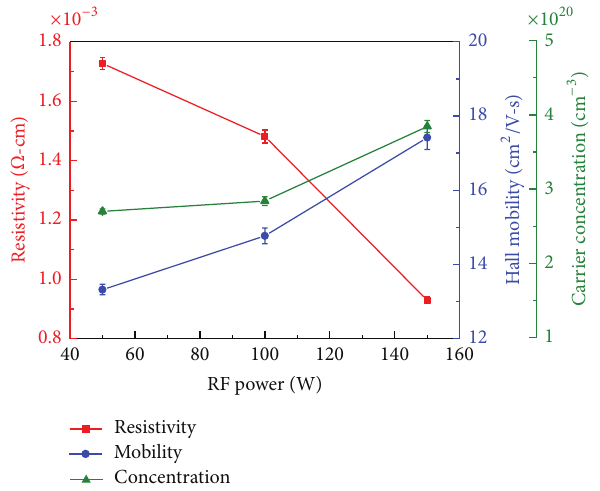
Figure 2: Carrier mobility, carrier concentration, and resistivity of the FZO thin films as a function of deposition power.